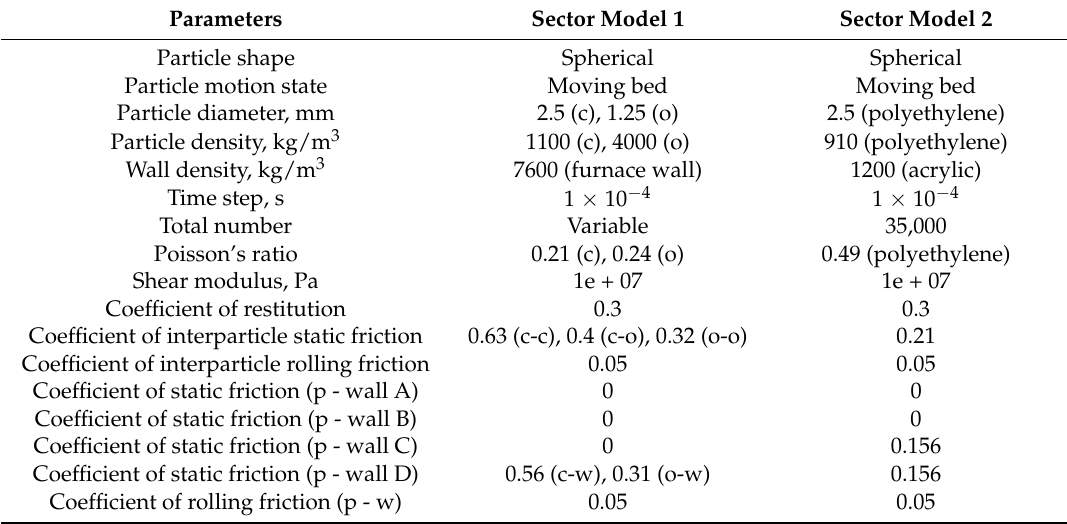
Table 3. Parameters of the particles in the DEM